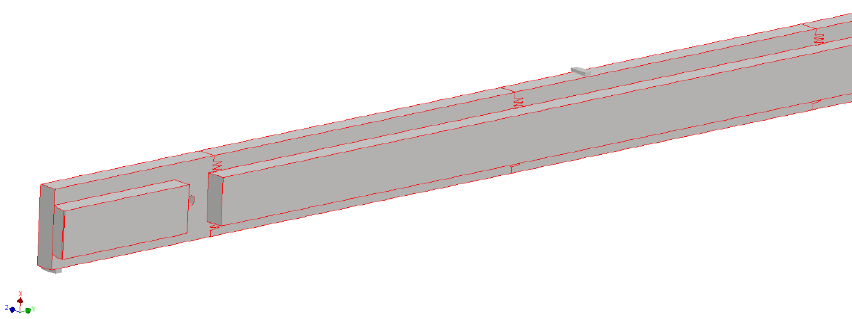
Figure 3. Fragment of a selected geometric model of a continuous C-version long frame made of glued material with a finger-jointed lamella length of 400 mm.